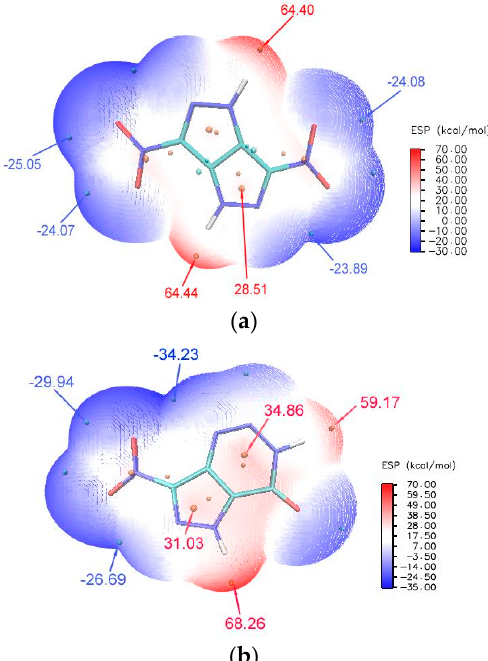
Figure 6. ESP-mapped surfaces of DNPP ( a ) and NPTO ( b ).